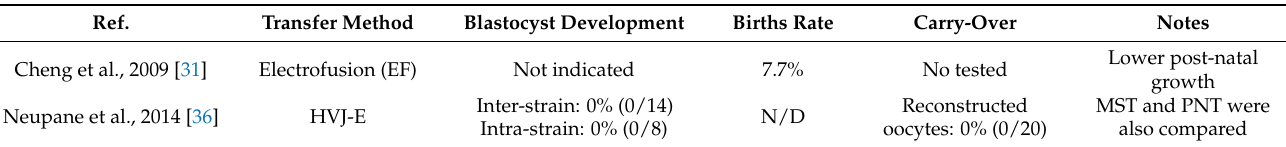
Table 2. GVT results in murine model.